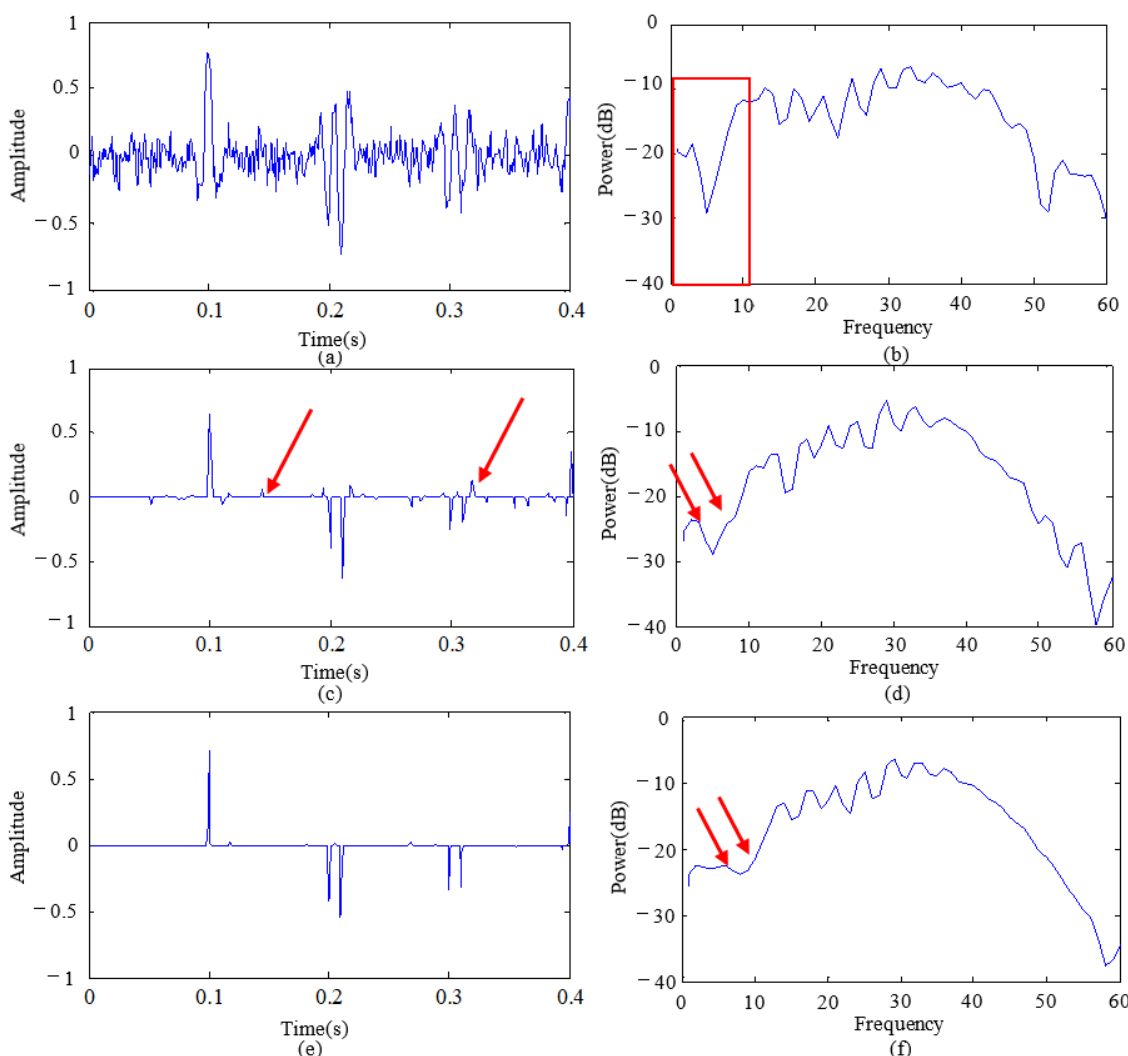
Figure 9. Comparisons of low frequency expansion when SNR = 3.14. ( a , b ) Noisy data and their frequency spectrum, ( c , d ) reflection coefficients estimated by CS and extended spectrum, ( e , f ) reflection coefficients estimated by proposed method and extended spectrum.